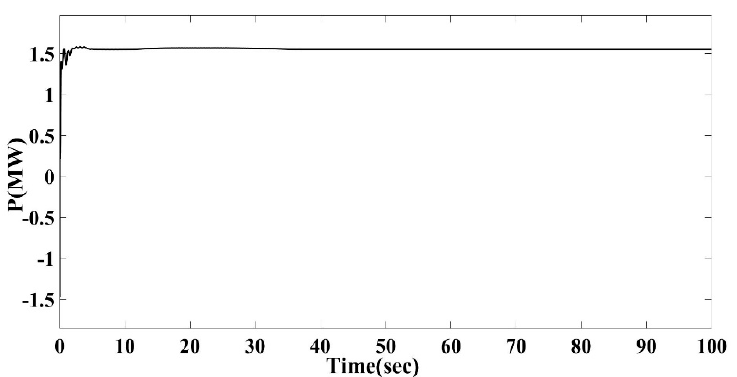
Figure 21. Active power response at 25th iteration. Figure 21 . Active power response at 25th iteration.